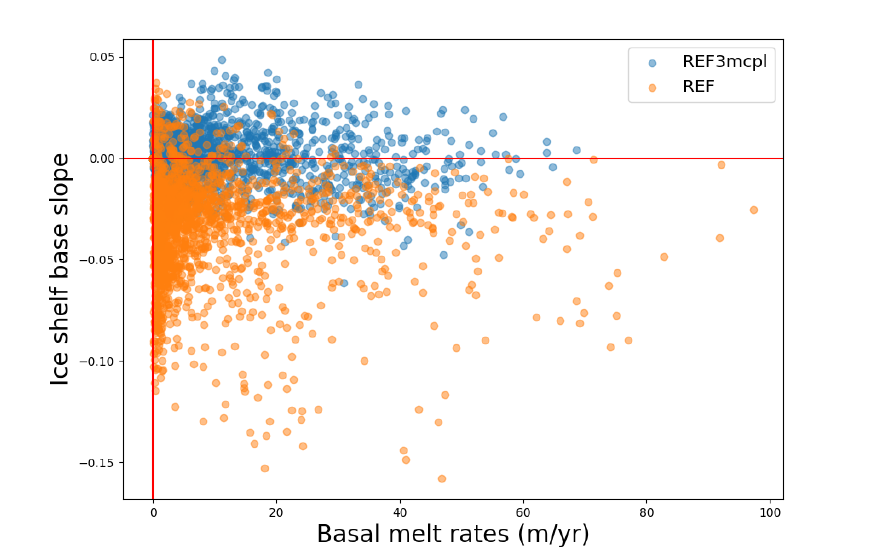
Figure A1. Scatter plot of the mean basal melt rates and the local slope of the ice shelf base. The local slope is computed as the sum of the zonal and meridional slopes and a positive value represents an upward slope towards the north or east.